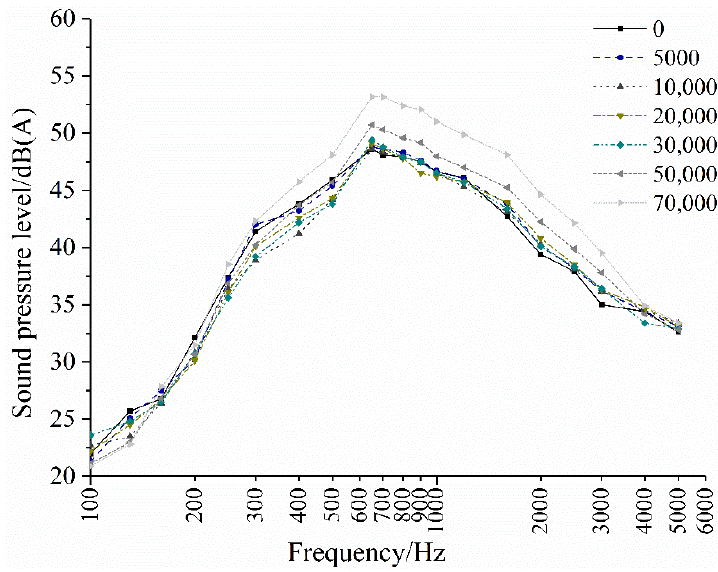
Figure 11. Changes in the OGFC pavement noise characteristics.